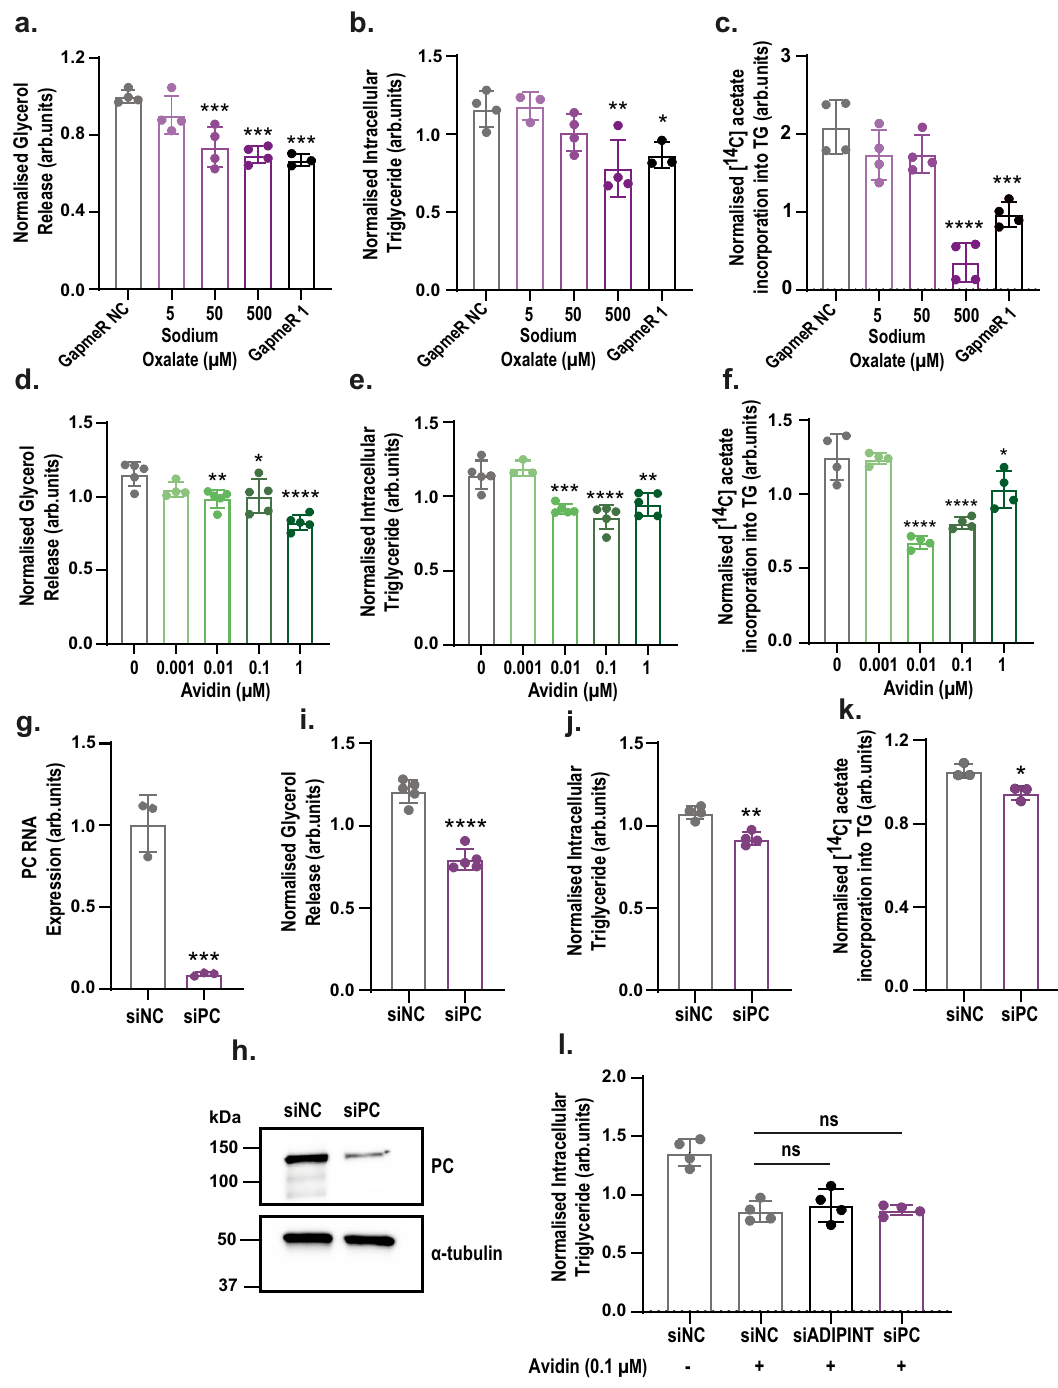
Fig. 5 Pyruvate carboxylase inhibition recapitulates the effects on lipid metabolism as seen with ADIPINT knockdown. a ( n = 3 – 4), d ( n = 3 – 5) Glycerol release (measure of basal lipolysis) b ( n = 3 – 4), e ( n = 3 – 5) intracellular triglyceride (TG) content and c ( n = 4) , f ( n = 4) insulin-stimulated [ 14 C] acetate incorporation into intracellular lipid (measure of lipid synthesis) in differentiated hADSC incubated with varying concentrations of ( a – c ) oxalate or ( d – f ) avidin compared to vehicle treated cells. ADIPINT knockdown using GapmeR 1 was used as a positive control for the effects on glycerol release, triglyceride content and lipid synthesis in oxalate treated cells. g PC RNA ( n = 3) and h protein expression following siPC knockdown compared with siNC transfected hADSC. i glycerol release ( n = 5) j intracellular triglyceride content ( n = 4) and k insulin-stimulated [ 14 C] acetate incorporation into intracellular lipid after PC knockown ( n = 3). l The intracellular triglyceride content of hADSC after + \ − avidin treatment and knockdown of either PC or ADIPINT. siADIPINT and siPC cells were compared with siNC cells treated with 0.1 µ M avidin ( n = 4). a – g and i – l each data point represents an individual experiment. One-way ANOVA with Dunnett ’ s post-hoc test assessed signi fi cance. Data are presented as mean values + /- SD. * p < 0.05, ** p < 0.01, *** p < 0.001, **** p < 0.0001. Source data are provided as a Source Data fi